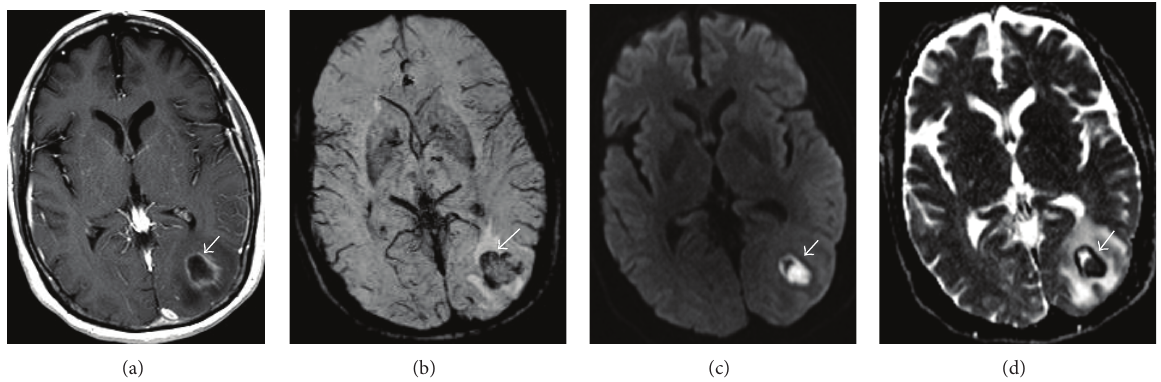
Figure 3: (a) Post gadolinium T1 SE image shows the ring enhancing wall of the abscess (arrow). (b) Susceptibility weighted image shows prominent hypointensity (arrow) in the wall from presence of hemorrhage. (c) Diffusion image demonstrates bright signals due to restricted diffusionfromthepusinthecenteroftheabscess.(d)Apparentdiffusioncoefficient(ADC)mapshowscorrespondingdarksignalsconfirming true restricted diffusion in the center of the